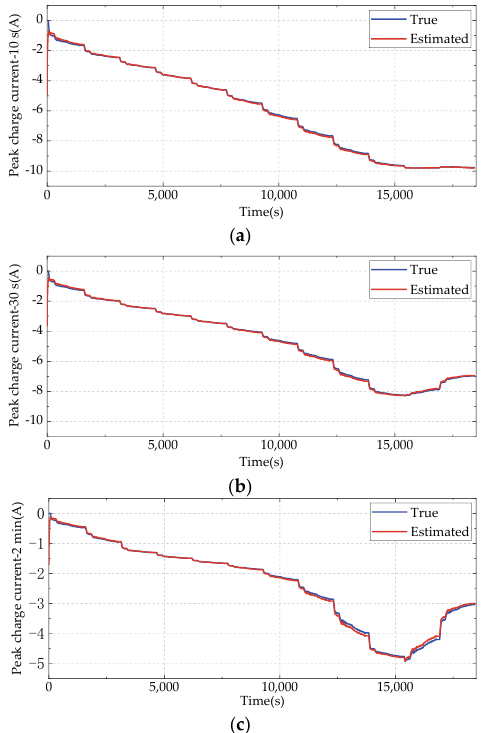
reduced, as is the value of the continuous peak charging power at the same moment. Ac- Figure 18. Results of peak charge current estimation in different time scales: ( a ) 10 s; ( b ) 30 s; ( c ) 2 Figure 18. Results of peak charge current estimation in different time scales: ( a ) 10 s; ( b ) 30 s; ( c ) 2 min. cording to the results listed in Table 2, the sustained peak charging power MARE at dif- min. ferent sustained charge times is less than 1.6% and the RMSE falls within the range of 2.3